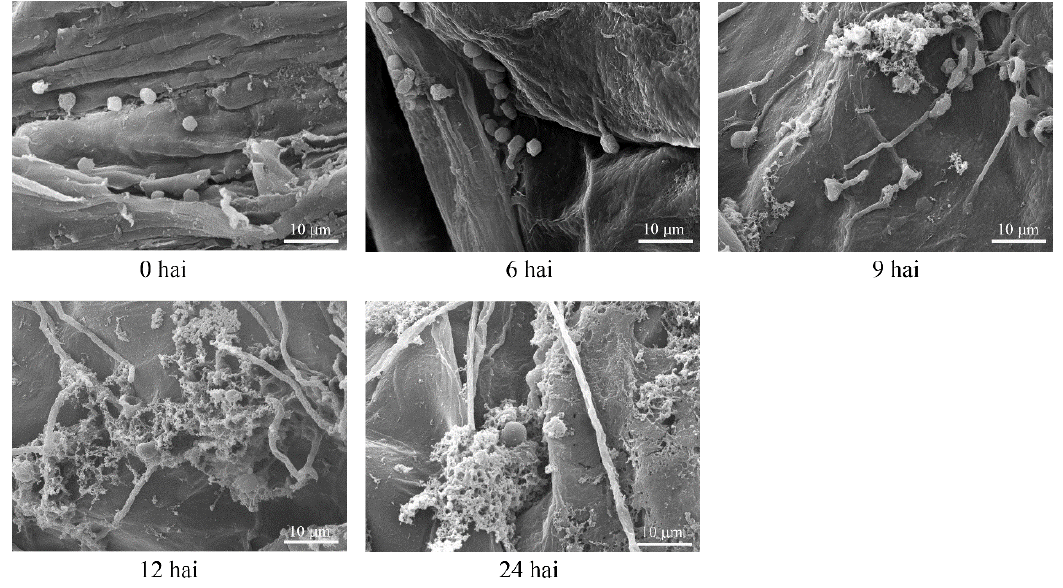
Figure 1. Scanning electron micrographs of Penicillium expansum -infected apple tissues at different time points.